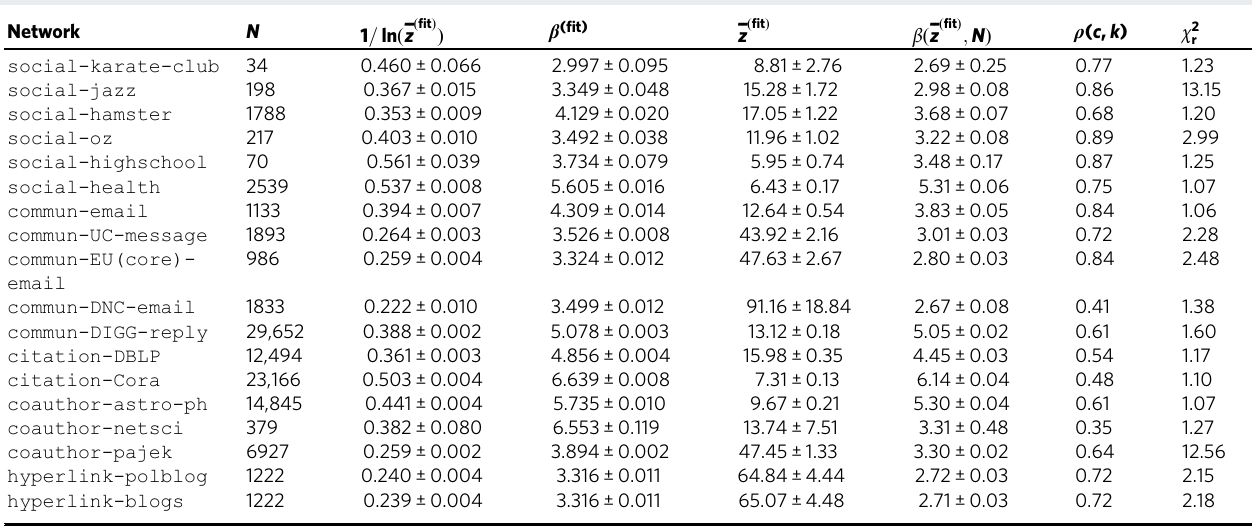
Table 2 Results for the largest components the Konect-SNAP networks.